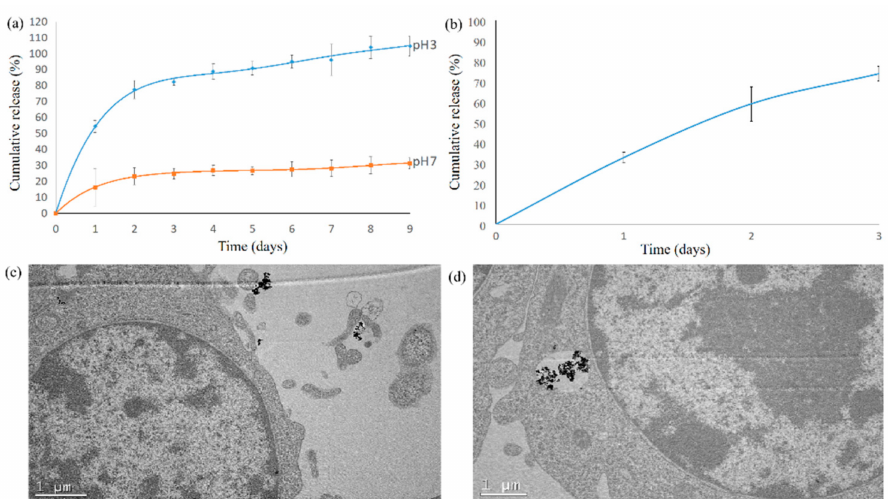
Figure 5. Release profile of curcumin. ( a ) The release profile of curcumin at pH 7 and 3, mimicking the conditions of the physiological environment and endosome/lysosome hybrid, respectively. ( b ) The drug release profile of Cur-SHAP co-cultured with RAW-264.7 macrophages; 70% of curcumin was consistently released within 2 d, presumably due to cellular activity. ( c ) TEM images of the interface of RAW-264.7 and Cur-SHAP particles prior to cellular uptake. ( d ) TEM images of Cur- SHAP particles transported to the lysosome, where the lysosome/endosome hybrid was inflated and ruptured due to the change in osmotic